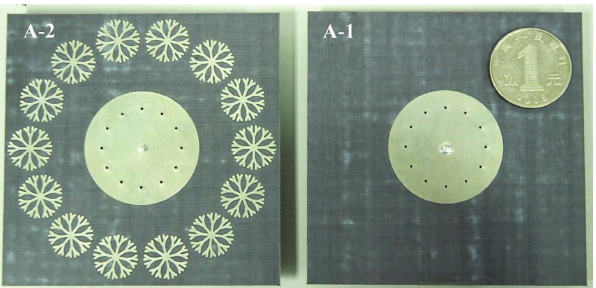
Figure 4: Photographs of the fabricated